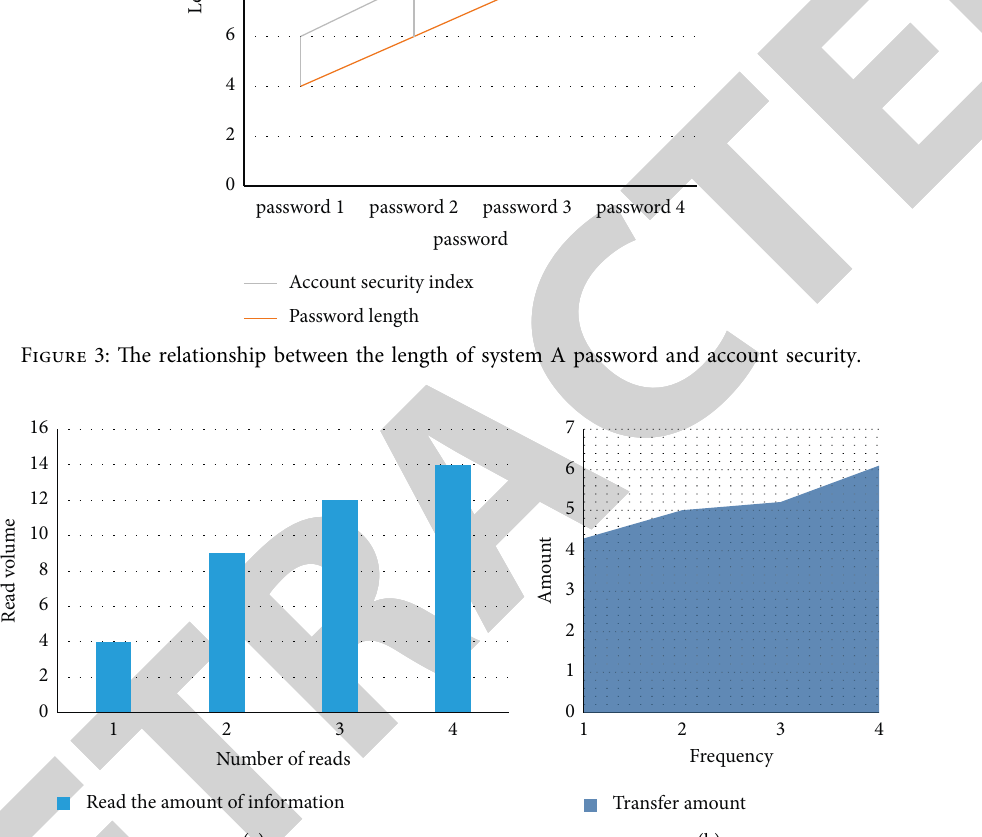
Figure 4: Difficulty of reading and transferring account information in system A. (a) Difficulty in reading information. (b) Difficulty in transferring information.